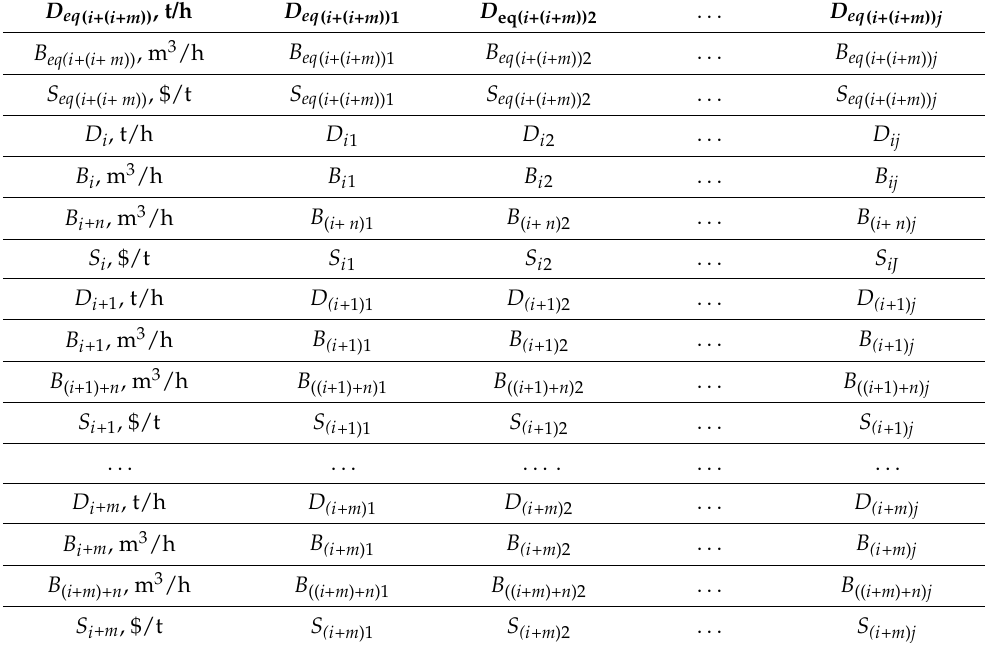
Table 4. Equivalent Boiler Unit Characteristics on the Forward Path of Solving the Dynamic Program- ming